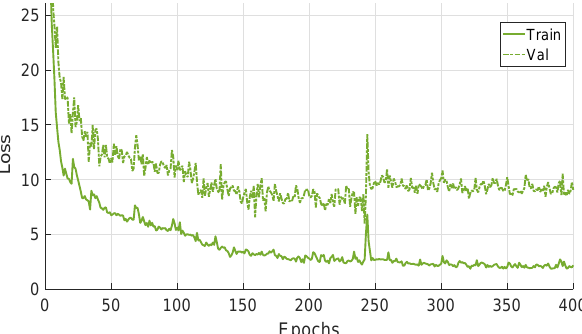
Figure 7. The training and validation losses for the network fine-tuned and validated with real image sequences, having a window size of